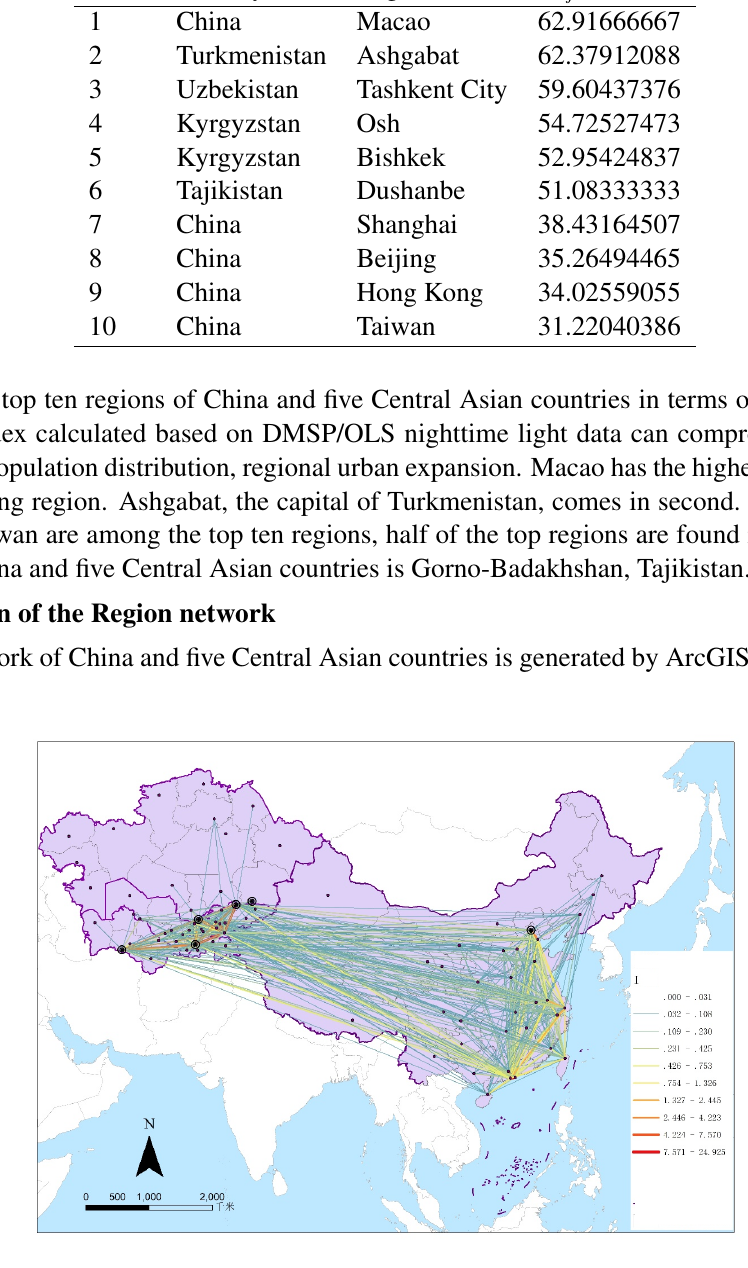
Fig. 3 The region network of China and five Central Asian